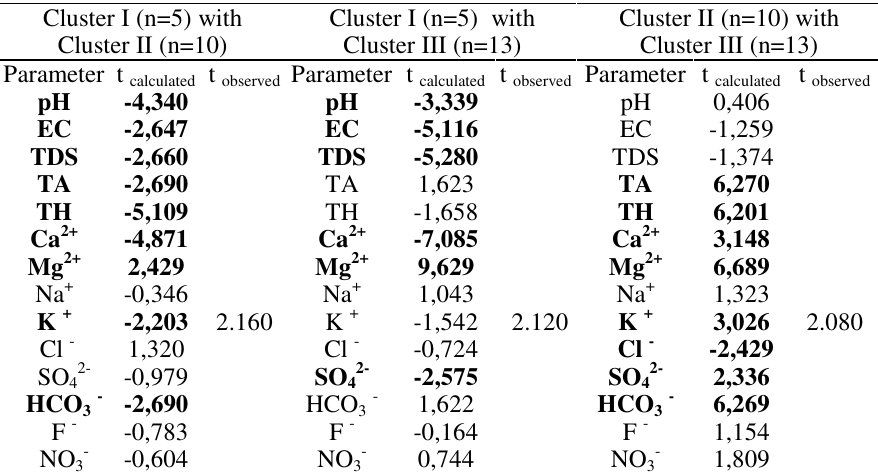
Table 6. Student test between